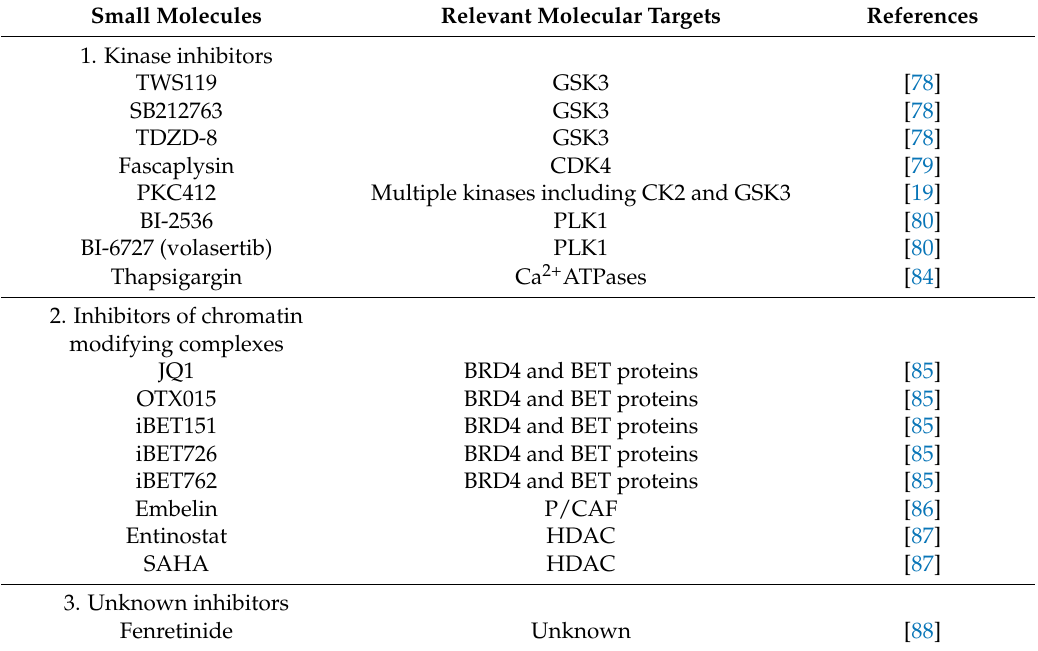
Figure 2. Targetable regulations of PAX3-FOXO1 activity. GSK3β, CK2, CDK4 and PLK1 phosphorylate PAX3-FOXO1 at various serine residues. The acetyltransferase enzyme P/CAF acetylates PAX3-FOXO1 at K426/K429 lysine residues. BRD4 acts as co-transcriptional activator of PAX3-FOXO1 at its DNA target sites. The mechanism by which HDAC regulates the mRNA expression level of PAX3-FOXO1 remains unknown. These chromatin modifiers, which modulate expression of PAX3-FOXO1 target genes, can be targeted by small molecule inhibitors. Table 2. List of small molecules reported to inhibit PAX3-FOXO1 activity. Small Molecules Relevant Molecular